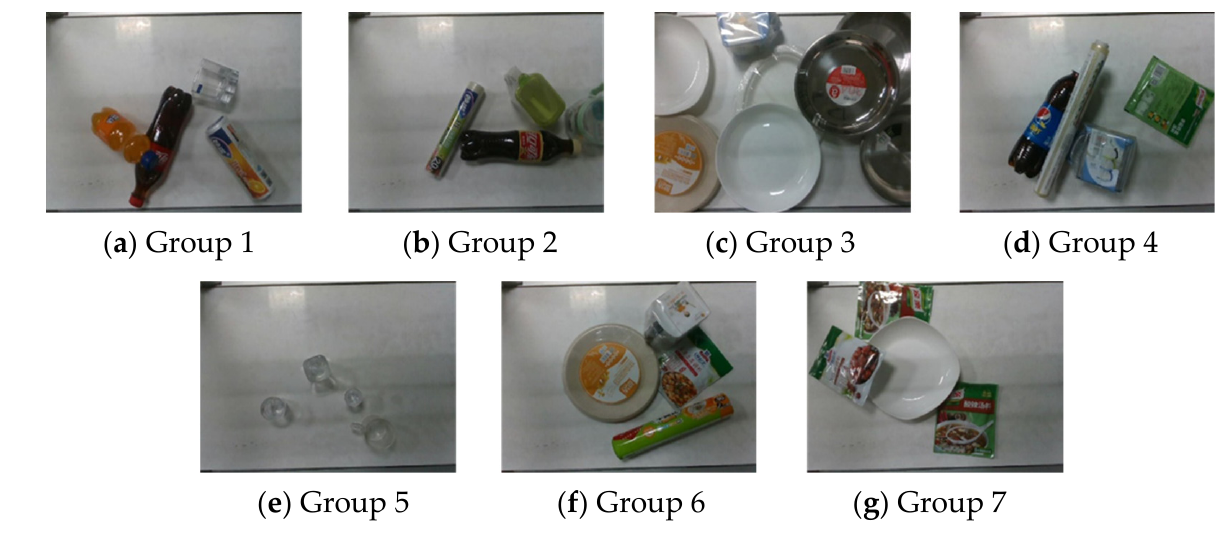
Figure 7. Objects in the training set of the OCIS dataset.